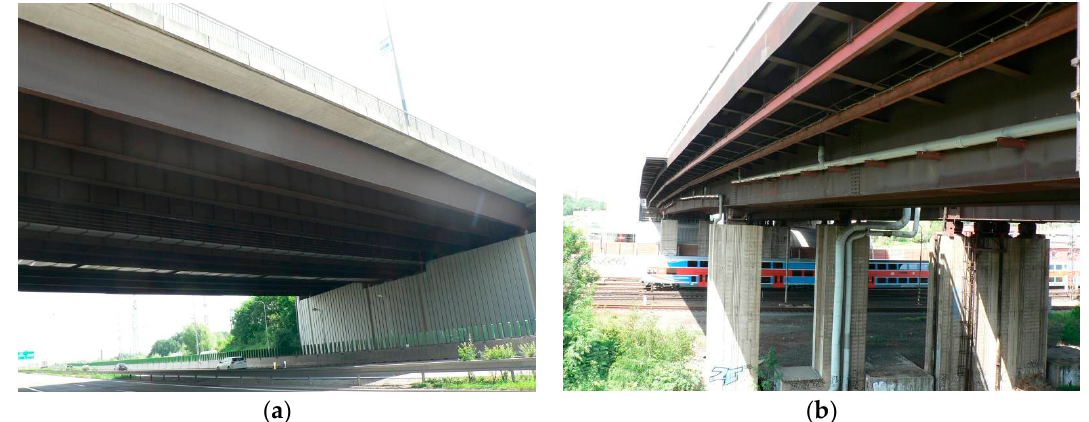
Figure 3. View at selected bridges for experimental testing: ( a ) Bridge No. 1 and ( b ) bridge No. 2.